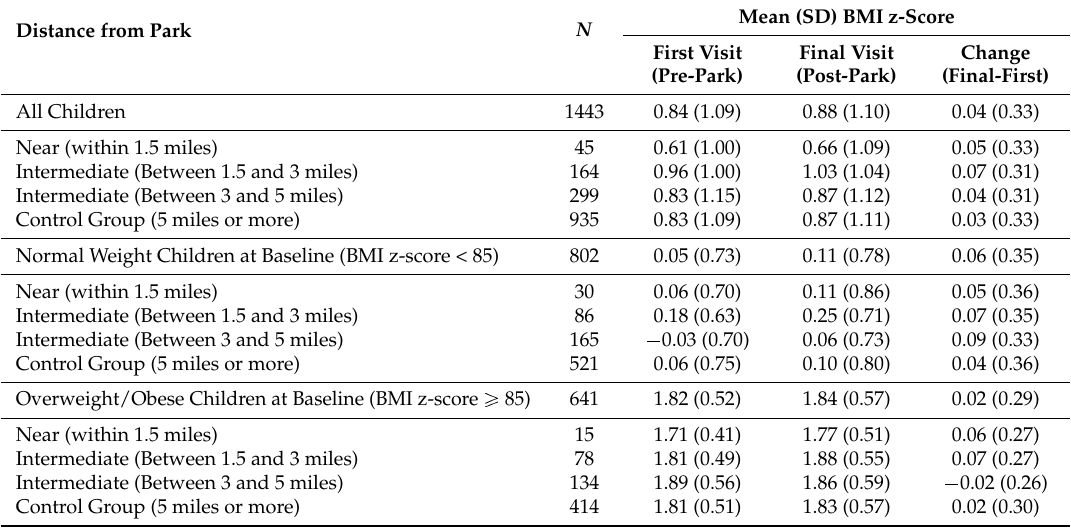
Table 2. Changes in BMI z-scores among children living at various distances from the